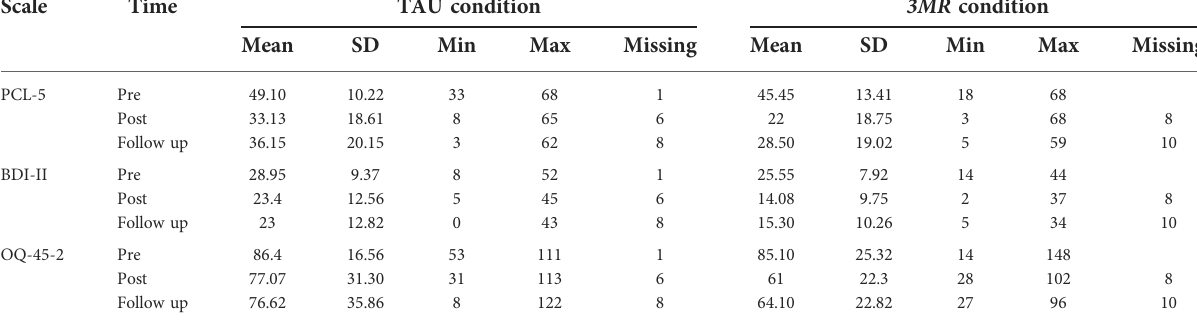
TABLE 3 Descriptives per scale per measurement moment and condition.